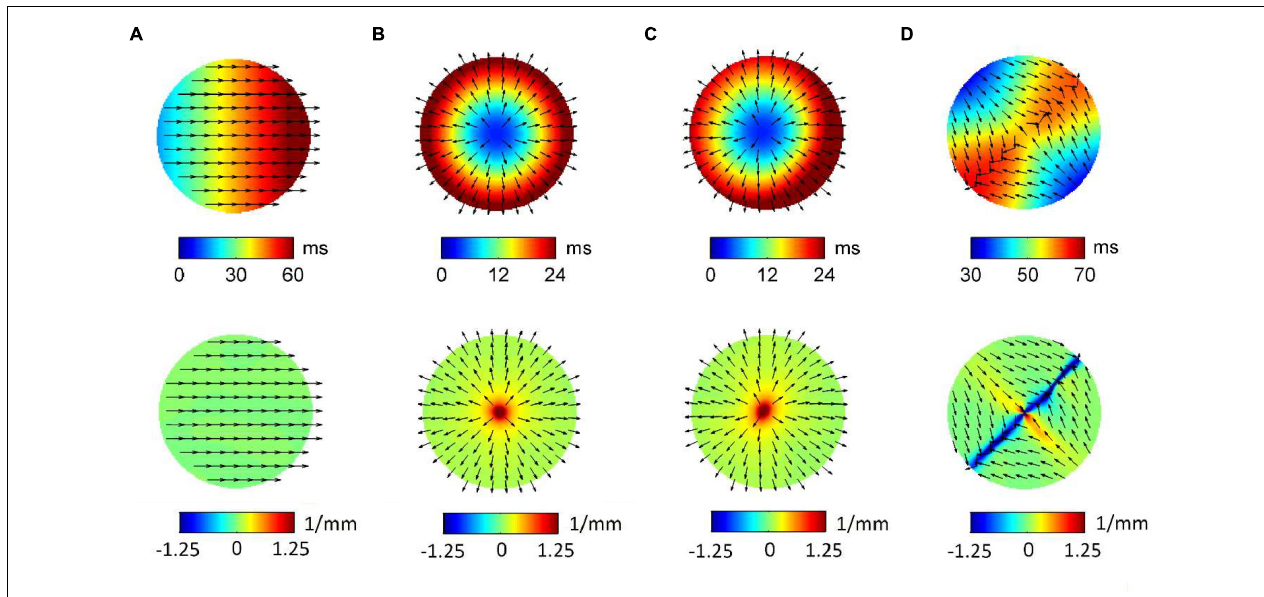
FIGURE 3 | Radial basis function-reconstructed activation (top) and divergence maps (bottom) corresponding to the simulated patterns in Figure 1 . Analytically determined conduction velocity vector fields are displayed on the maps as normalized arrows indicating the direction of wave propagation. Divergence maps quantify pattern properties, assigning zero divergence values (green) to planar wave propagation (A) , positive divergence values (red) to focal sources (B,C) , and negative divergence values (blue) to collision lines (D) .